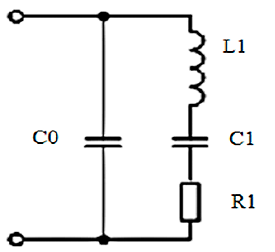
Figure 4. Electrical model of a piezoelectric transducer.